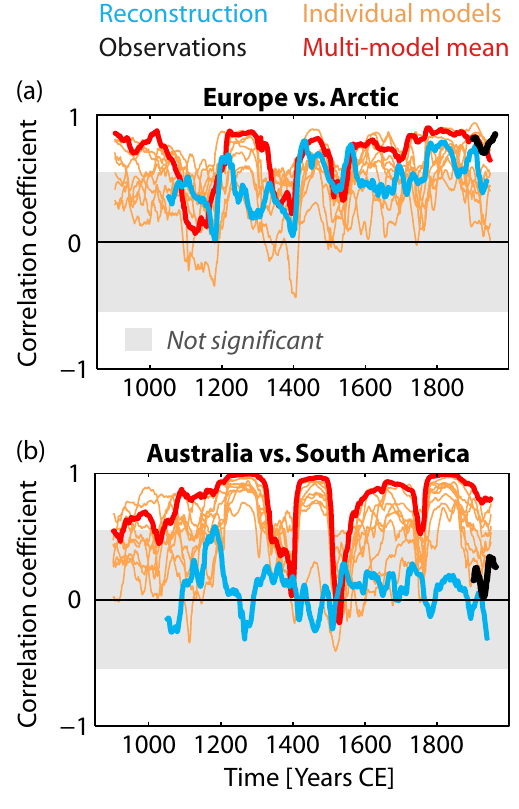
Figure 7. One-hundred-year moving Tukey window correlations between selected PAGES 2k regions for the PAGES 2k reconstruc- tions (blue) and PMIP3 models (eight models in orange, multi- model mean in red) and observations from HadCRUT4 (Morice et al., 2012, black). Each 100-year segment is linearly detrended be- forehand. Grey shading illustrates correlations that are not signif- icant at the 5% level. (a) Correlation between Arctic and Europe as an example of good agreement of model and reconstruction. (b) Correlation between Australia and South America as an example of poor agreement. For all other combinations see Fig.